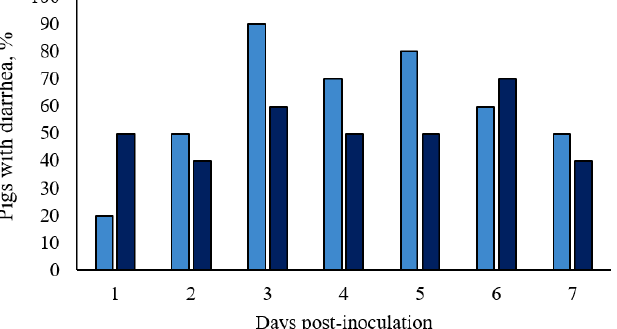
Figure 3. Incidence of diarrhea of growing pigs orally challenged with Salmonella Typhimurium. ( ■ ) Pigs orally challenged with 1 × 10 8 CFU of Salmonella Typhimurium; ( ■ ) Pigs orally challenged with 1.5 × 10 8 CFU of Salmonella Typhimurium. No differences between treatments were observed by Fisher’s exact test ( p > 0.05).